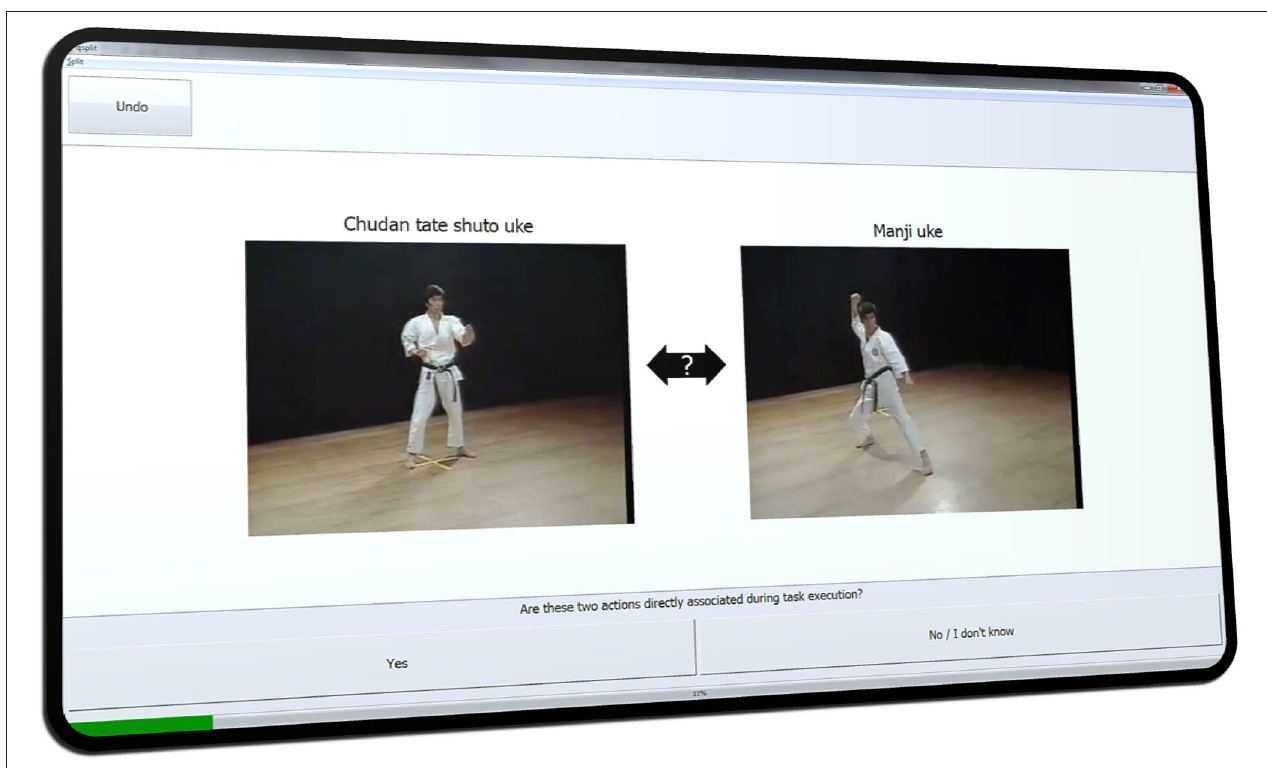
FIGURE 1 | User interface of the QSplit software for the SDA-M split procedure showing two basic actions (karate blocking techniques) from the Kanku-dai movement